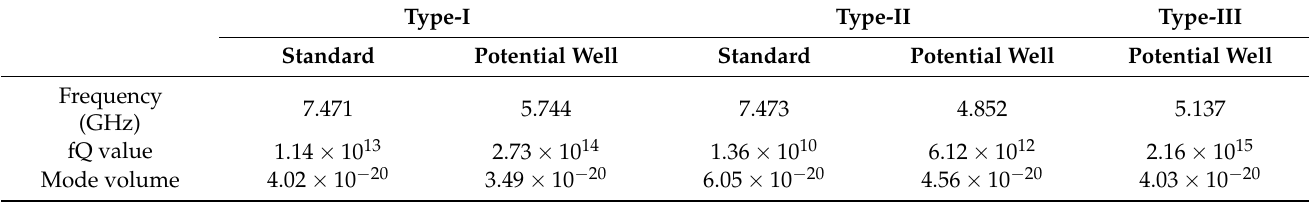
Table 2. The Q value and the mode volume of the SS mode in the three types of fishbone structure.